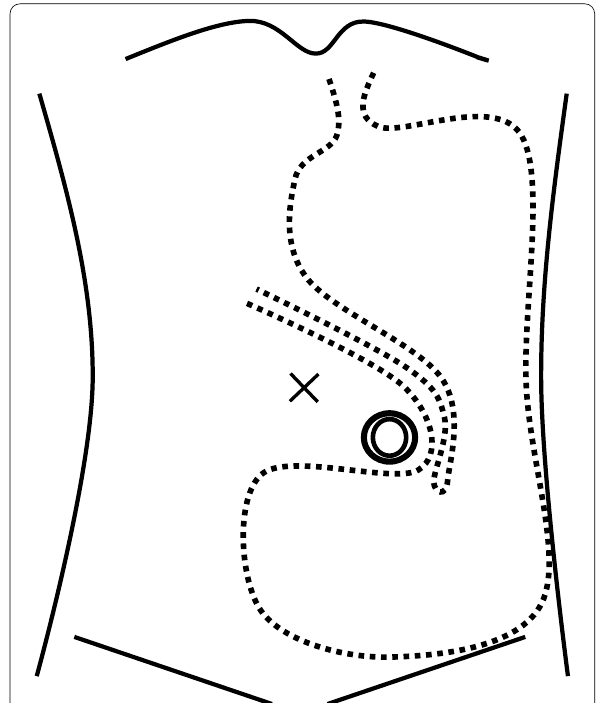
Fig. 1 The stomach dilates after eating and descends into the pelvis through the space between the lifted sigmoid colon and the lateral abdominal wall. The antrum is obstructed by the lifted sigmoid colon, resulting in the internal hernia of the stomach. A dotted line and a double circle indicate the stomach and the sigmoid colostomy, respectively